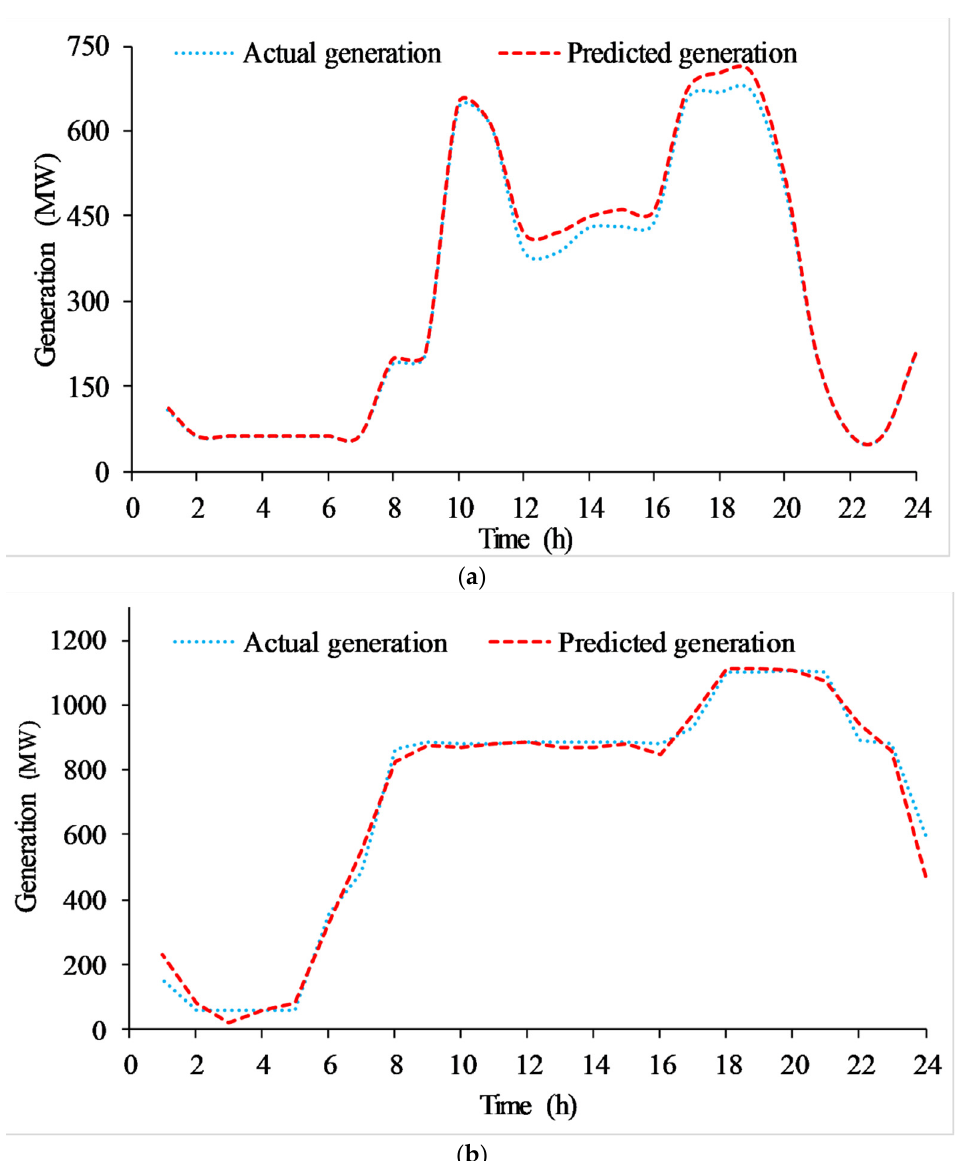
Figure 14. Generation profile of the Tianshengqiao plant 2: ( a ) winter season; ( b ) summer season.